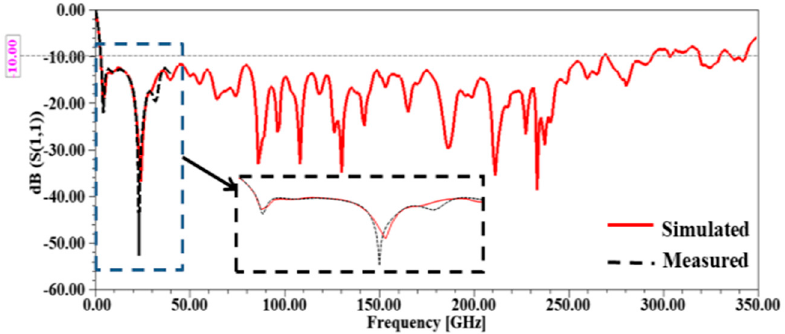
Figure 12. Simulated and measured return loss of the proposed SWB monopole antenna.